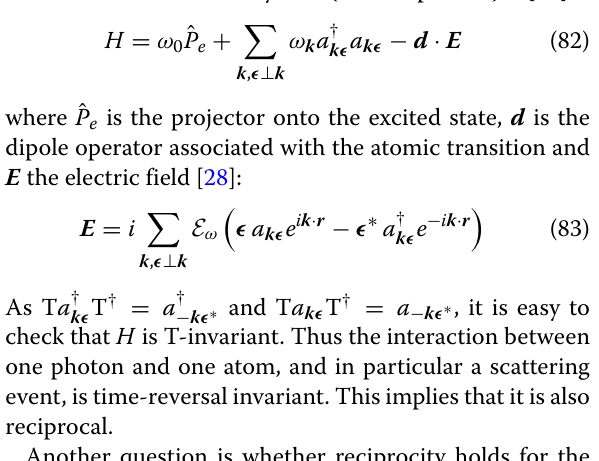
Fig. 1 CBS experimental set-up, see [37]. A laser probe beam is illuminating the scattering sample and the retro-reflected light is collected on a cooled CCD camera where a 2D image of the angular profile of the signal is recorded. Several optics help select the polarization of the incoming light and of the reflected light. In the helicity-preserving channel, the incoming light is circularly polarized (say left) while the reflected light has the orthogonal (right) circular polarization. In this channel, at exact backscattering, we thus have (cid:5) (cid:3) = (cid:5) ∗ and k (cid:14) = − k and both beams have the same (positive) helicity with respect to their respective propagation axis. In this case, breaking reciprocity can only come from a level degeneracy in the atomic internal ground state, see Eq. (85). Note that, for spherically-symmetric scatterers, the single scattering contribution is filtered out in the helicity-preserving channel allowing to observe, for these scatterers, the highest possible CBS enhancement factor, namely a peak-to-background value of